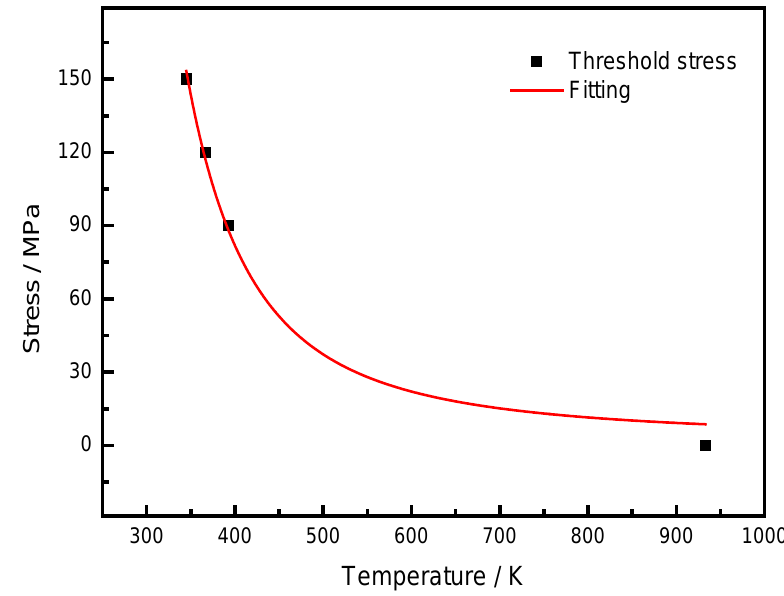
Figure 12. The threshold stresses and fitting curve. Table 2. Creep-constitutive parameters for AA2024 aluminum alloy.